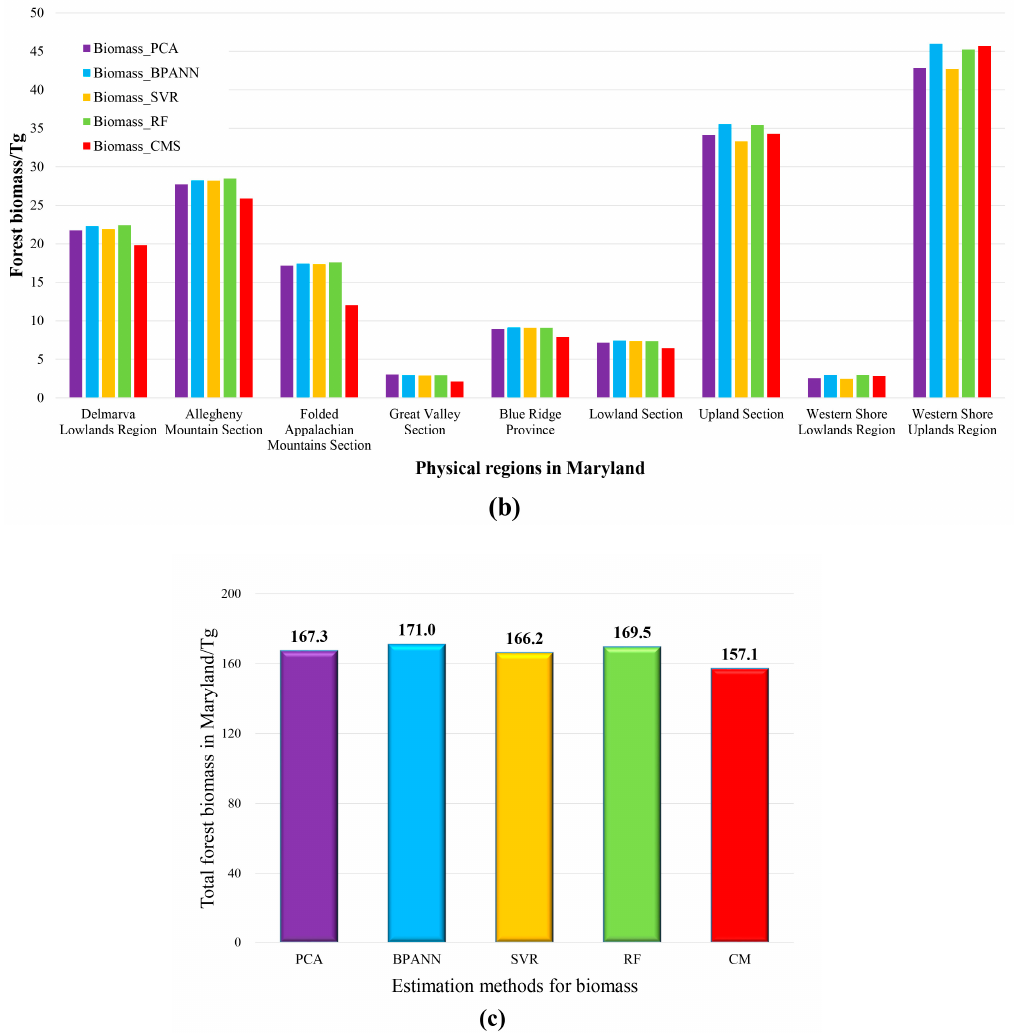
Figure 10. The forest aboveground biomass in Maryland. ( a ) Statistical forest biomass values of each county; ( b ) statistical forest biomass values of each physical region; and ( c ) the total biomass estimated by all models.